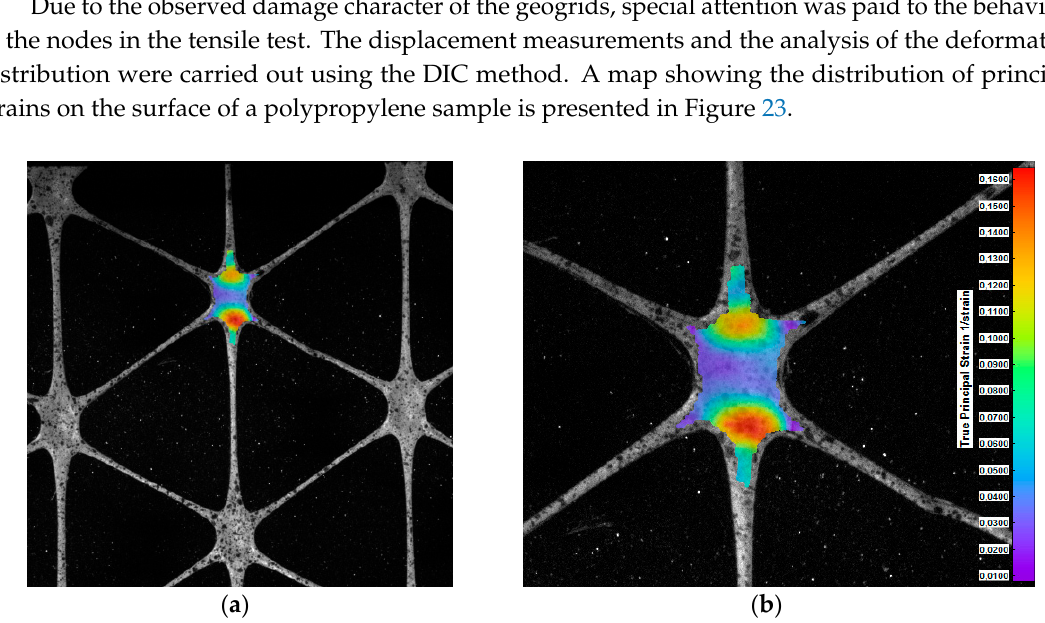
sample: ( a ) Geogrid view; ( b ) close-up of the node [38]. ( a ) Geogrid view; ( b ) close-up of the node